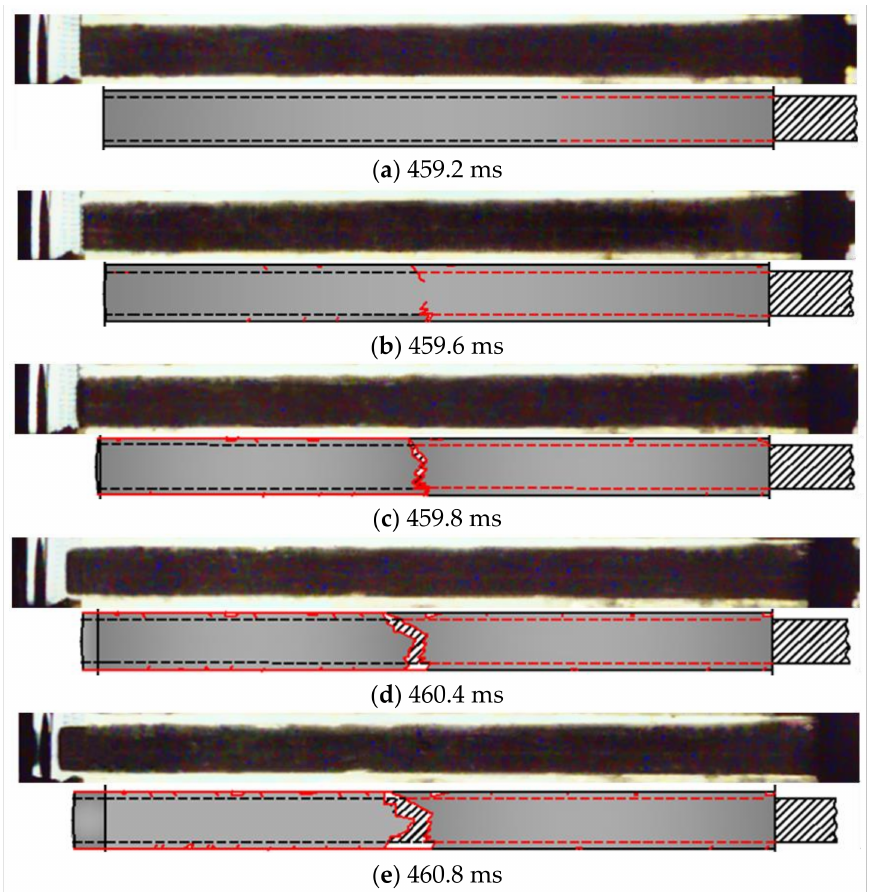
Figure 9. Debonding failure process of anchorage